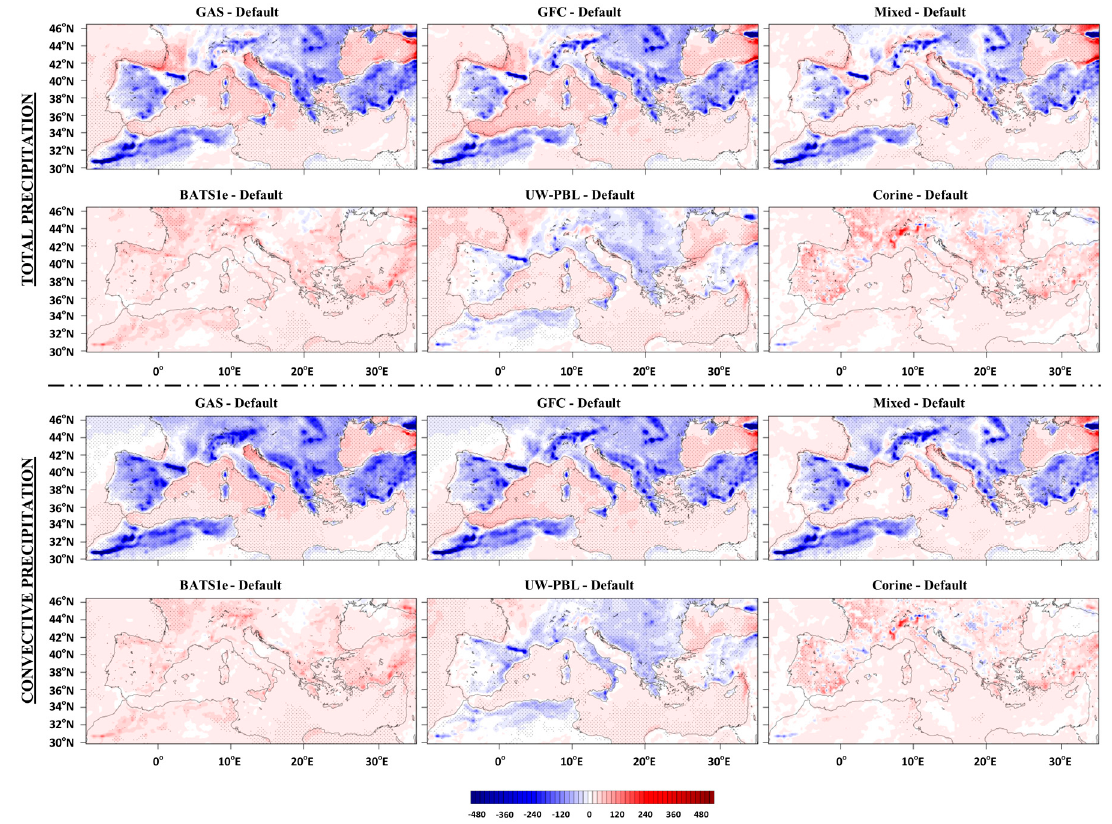
Figure 6. Differences in total and convective precipitation from the default simulation for the performed simulations during summer. The statistical significance of the differences in the maps is represented by the dotted